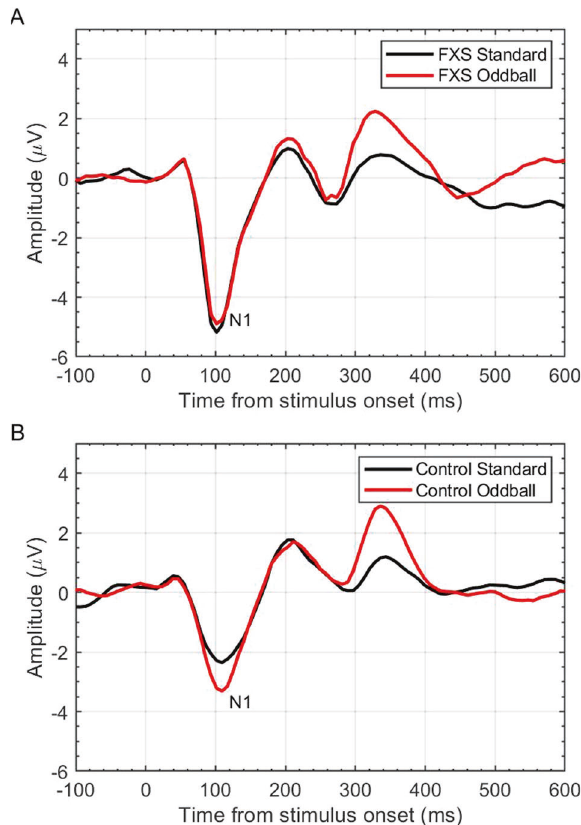
Fig. 1 Example of N1 ERP in response to standard and deviant tone presentation in auditory oddball task for FXS and for controls. A The exaggerated N1 amplitude (reported in microvolts ( μ V), across time (ms)) response to both standard and oddball tones as observed in FXS. B The neurotypical control response; exagger- ated N1 amplitude to oddball tone, but attenuated N1 amplitude to the repeated standard tone.